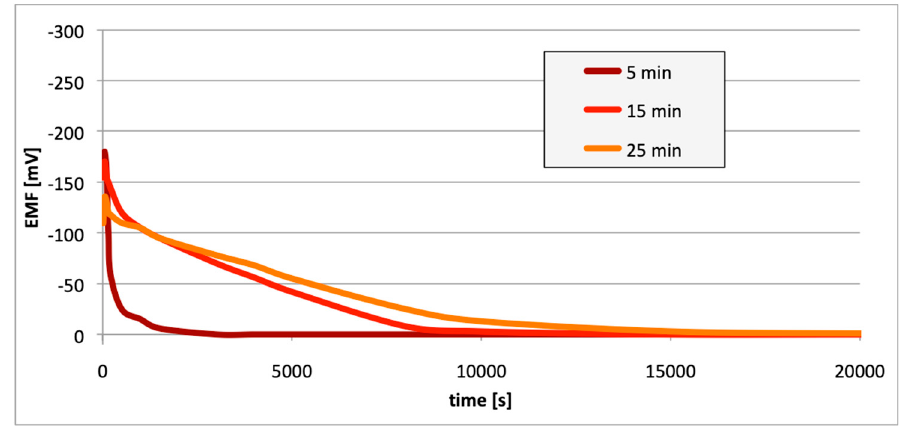
Figure 10. Decrease of cell EMF in time accompanying hydrogen desorption (EN AW-1050A). Hydrogenation time: 5, 15, and 25 min.